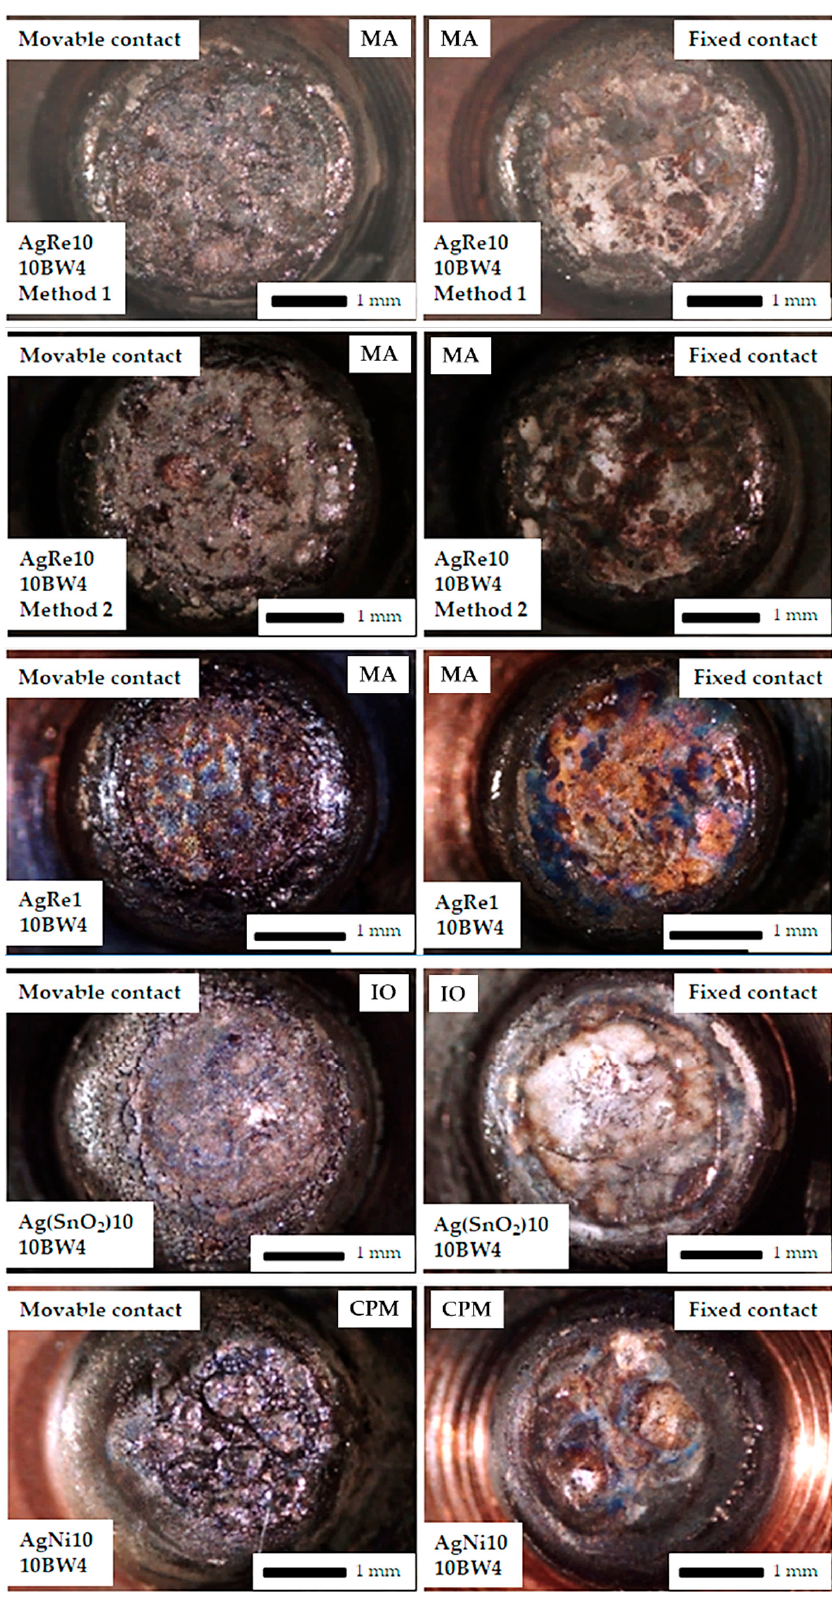
Figure 7. Macro photographs of contact surface after the arc erosion testing DC current = 10 A, voltage = 550 V, MA = mechanical alloying, IO = internal oxidation, CPM = classical powder metal- lurgy.